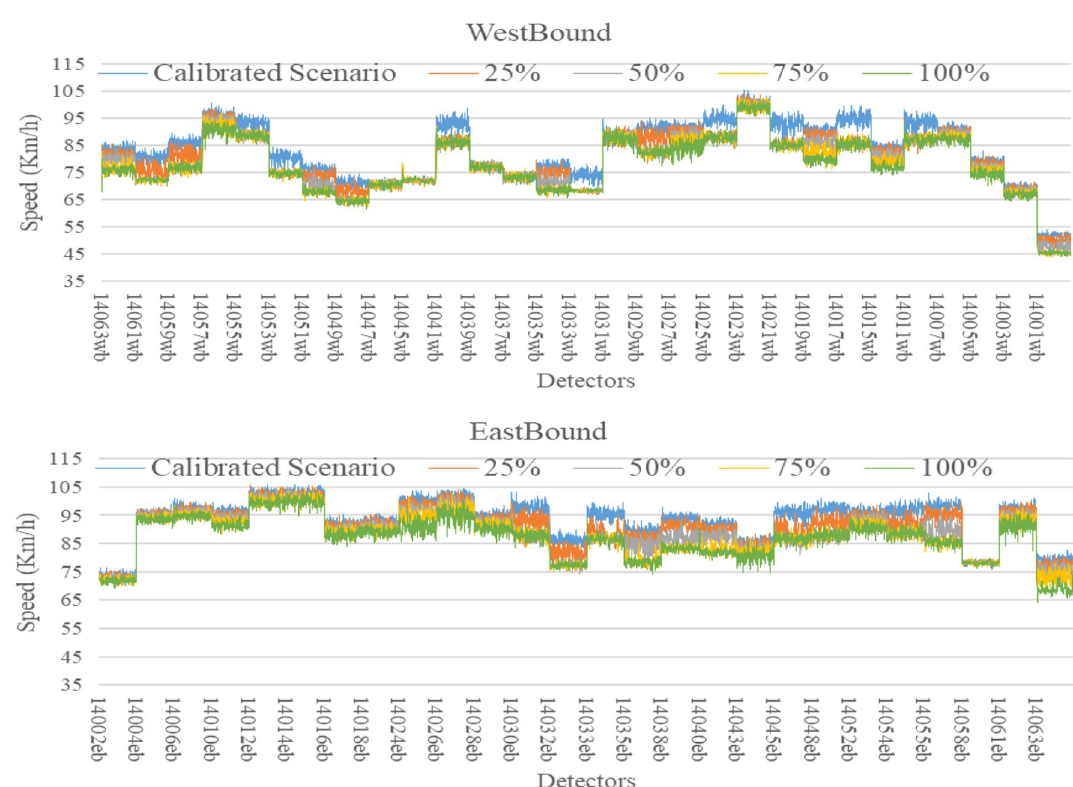
Figure 11. Future speed data generated from